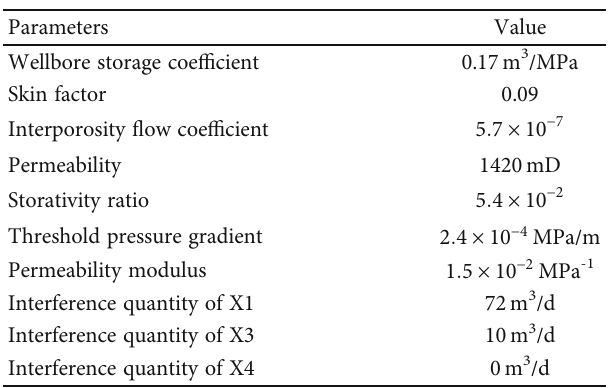
Table 2: The interpretation results.